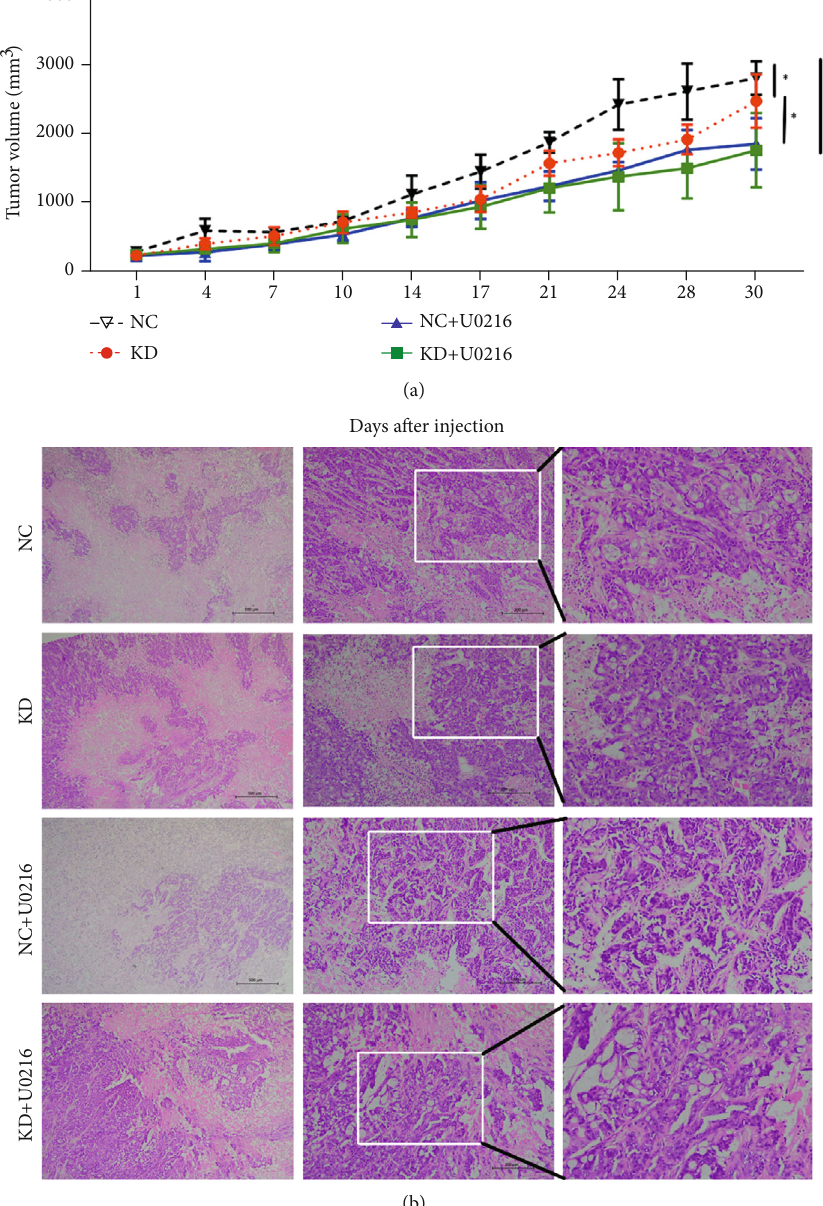
Figure 5: E ff ects of GRHL3 on tumorigenicity of CRC cells in vivo. (a) Tumor volumes of di ff erent groups. ∗ P < 0 : 05 , ∗∗ P < 0 : 01 vs. mouse inoculated cells transfected with NC. (b) The HE staining of the